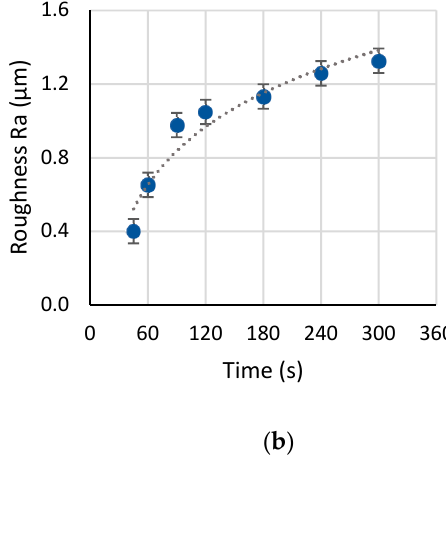
Figure 4. X-ray diffractograms of the coated Ti for the different PEO treatment times. The coating porosity almost linearly increased with the PEO treatment time (Figure 5c); starting with 2–3% at 45–60 s, it reached 6% by 300 s. The mean pore diameter obtained from the lognormal distribution increased from 0.7 to 1.2 µ m during the treatment (Figure 5e). The content of the anatase linearly decreased with the treatment time (Figure 5f) starting from 83% at 45 s to 63% at 300 s. It should be pointed out that at 90 s of the PEO, all the analyzed parameters showed a deviation toward the increase over the general regularity: the coating thickness, roughness, porosity, and pore diameter were significantly higher than expected. Compared with the current density (Figure 1a), we can expect this to be an effect of the current peak ranging from 30 to 120 s when the current density is higher than the passivation current density value between 10 and 20 s.